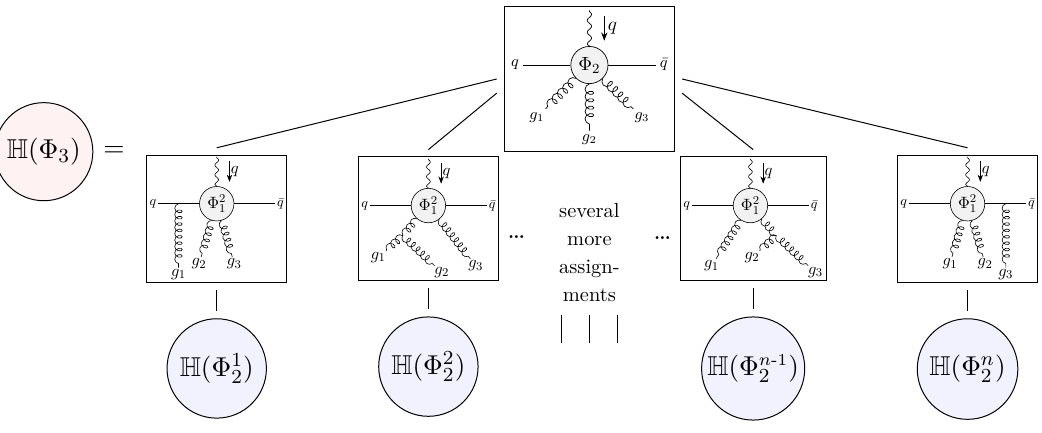
Figure 5 . Histories for two additional gluons: an individual gluon can be recombined with the other partons in several ways, leading to several underlying states with one additional gluons. Each of these underlying states leads to a parton shower history illustrated by figure 4, i.e. the history exhibits a recursive structure.